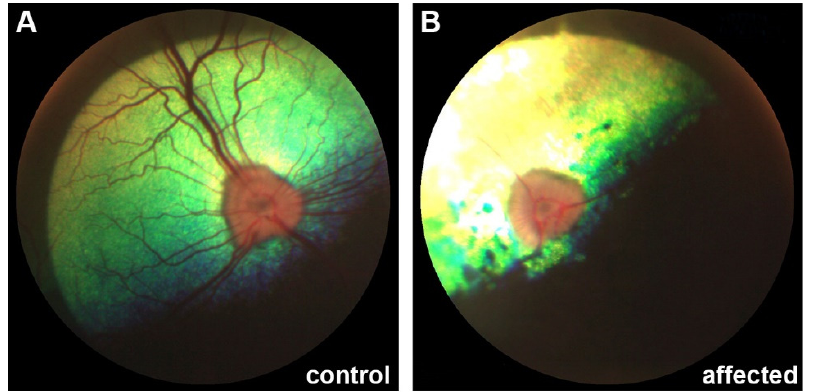
Figure 2. Ophthalmological phenotype of DSRA affected dogs. ( A ) Retina of a control Cane Corso; ( B ) Retina of a 5-months-old DSRA affected Cane Corso displaying signs of progressive retinal atrophy (PRA).